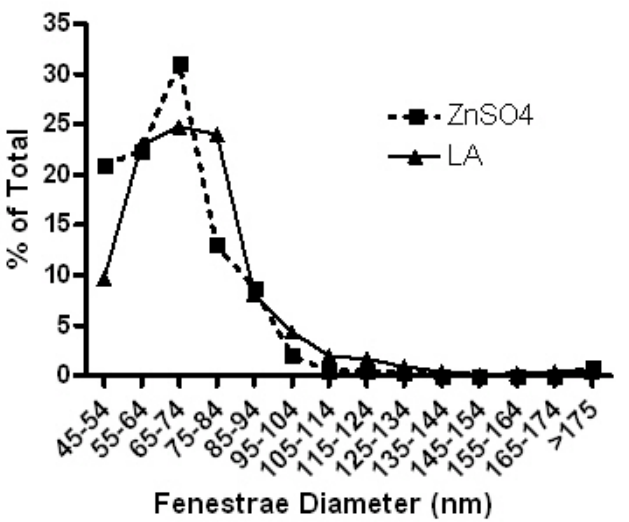
Figure A1. Distribution of fenestrae diameter induced by zinc or LA. Graphical representation of data in Table A1. The distribution of fenestrae diameters was similar in LA- and ZnSO 4 -treated cells.